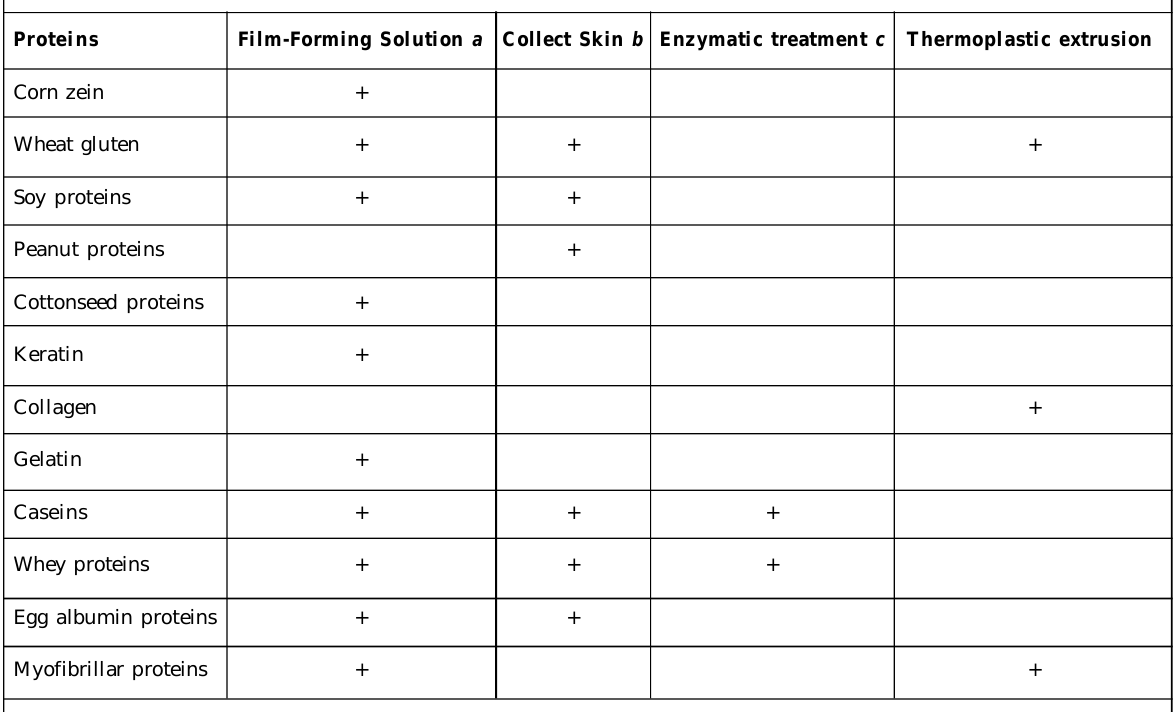
Table 3: Main proteins used to produce edible films, Adapted from Cuq et al ., 1998